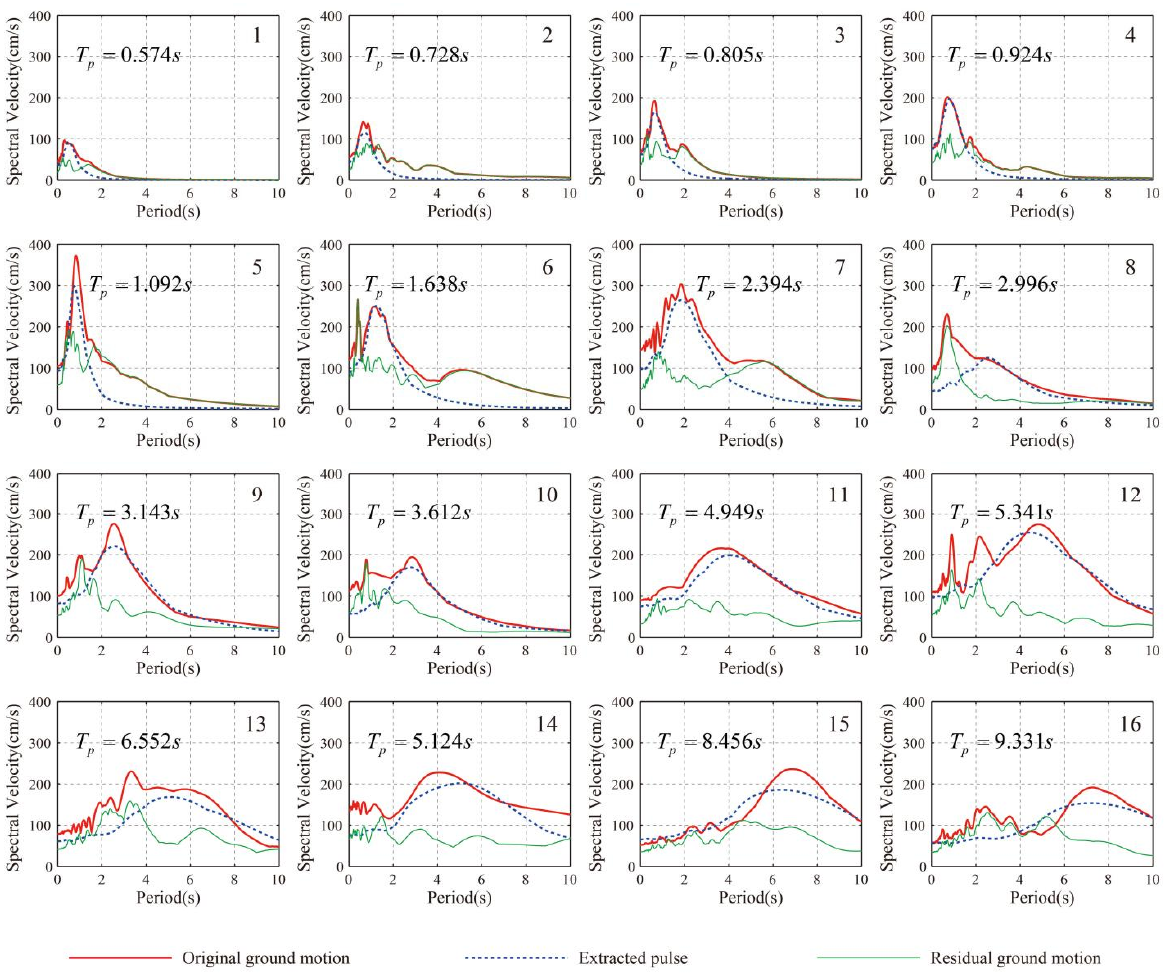
Figure 9. Velocity spectra of the original ground motion, extracted pulse, and residual ground motion for ground motions in Table 1.